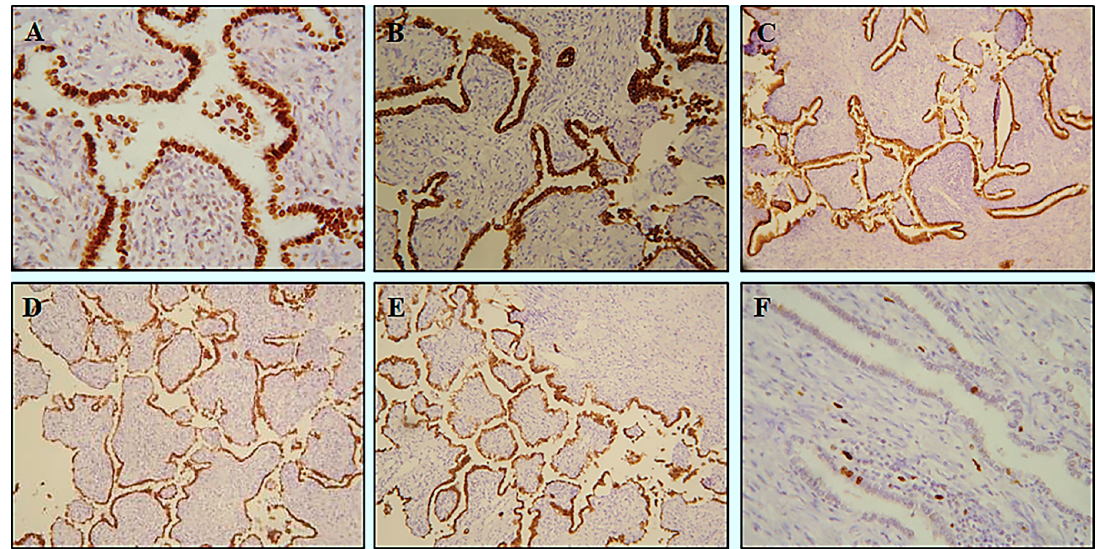
Figure 2. A large panel of antibodies was performed. The epithelial cells were positive for TTF-1 (clone 8G7G3/1, DAKO Cytomation, Glostrup, Denmark; dilution 1:100) ( A ), Napsin A (clone IP64, Novocastra TM HD, Leica Biosystems, Newcastle, UK; dilution 1:400) ( B ), Surfactant B (Novacastra TM HD Leica Biosystems, Newcastle, UK; dilution 1:50) ( C ), Cytokeratin 7 (clone OV-TL 12 / 30, DAKO Cytomation, Glostrup, Denmark; dilution 1:100) ( D ), pancytokeratin (clone AE1 / AE3, DAKO Cytomation, Glostrup, Denmark; dilution 1:100) (MNF-116) ( E ) and negative for Synaptophysin (clone 27G1, Novocastra TM HD, Leica Biosystems, Newcastle, UK; dilution 1:100) and Chromogranin A (clone 5H7, dilution Cytomation, Glostrup, Denmark; dilution 1:100). The neuroendocrine tumor differentiation was excluded. The Ki-67 (clone Ki-67P, Novocastra TM HD, Leica Biosystems, Newcastle, UK; dilution 1:100) proliferative index was <1% ( F ), suggesting a low rate of growth and dismissing the hypothesis of a papillary adenocarcinoma. Pneumocytoma (so-called “sclerosing hemangioma”) was also ruled out based on the lack of sclerotic stroma, foamy histiocytes, and hemosiderin deposits and the overall absence of epithelial markers (TTF-1, Cytokeratin7, MNF-116 and Napsina A) in the underlying stroma. Likewise, the abundance of papillary structures and the features of the stroma dismissed the diagnosis of a pulmonary adenofibroma. The final diagnosis was in favor of a “peripheral pulmonary papillary tumor”. The invasive behavior of the tumor cells with foci of invasiveness towards the pericapsular tissue suggested the definition of “undetermined malignant potential”. At the last follow up, six years after surgery, no recurrence or metastases were reported in this patient.